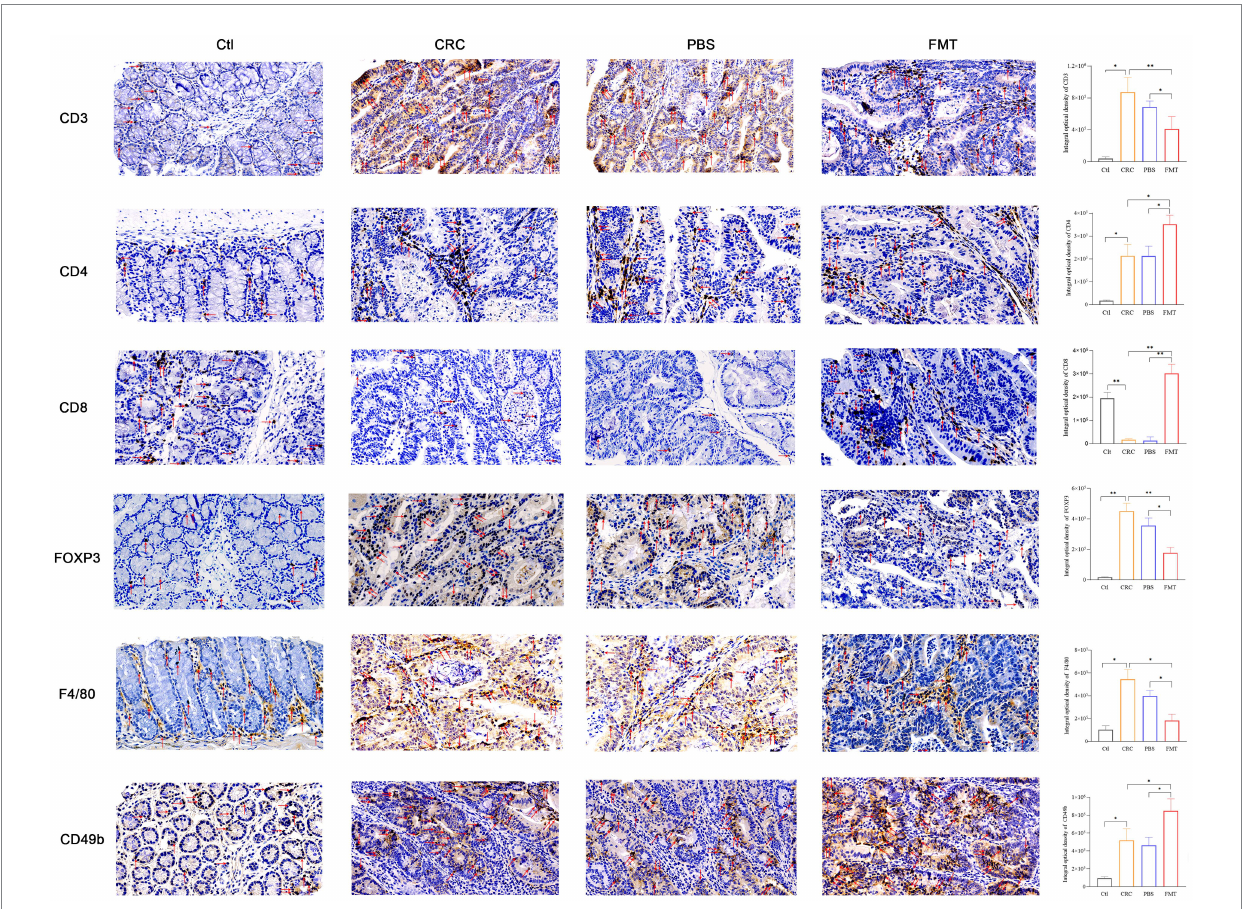
FIGURE 3 FMT enhanced immune cells mediated anti-cancer efficacy. The cytomembrane and cytoplasm of positive cells was stain brown. Microscopic photography scanning system (Zeiss) was used to record the images of intestinal tissue section of mice in Ctl, CRC, PBS and FMT groups, respectively. The average optical density of all immunohistochemically stained specimens was analyzed by Image J system. * p < 0.05, ** p < 0.01, n =